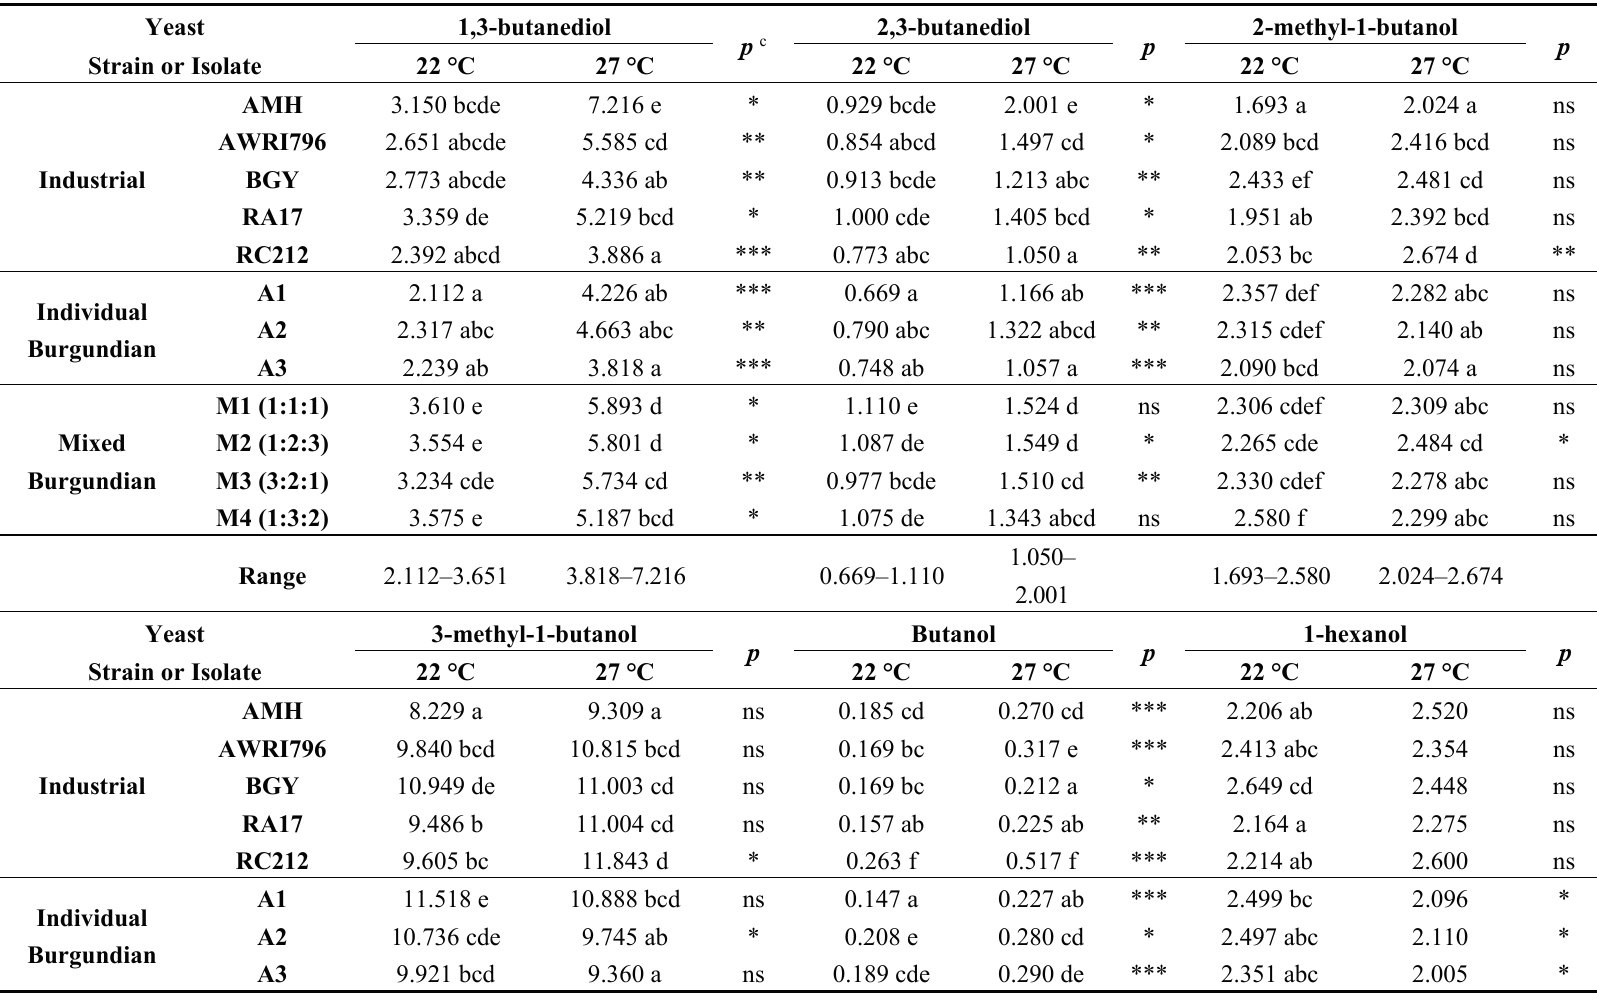
Table 2. Higher alcohols (mg·L − 1 ) a,b in Pinot noir fermented with industrial strains and individual- and mixed-Burgundian S. cerevisiae isolates at 22 °C and 27 °C. For each determination, strain and temperature effects are shown with subscripts and p values,